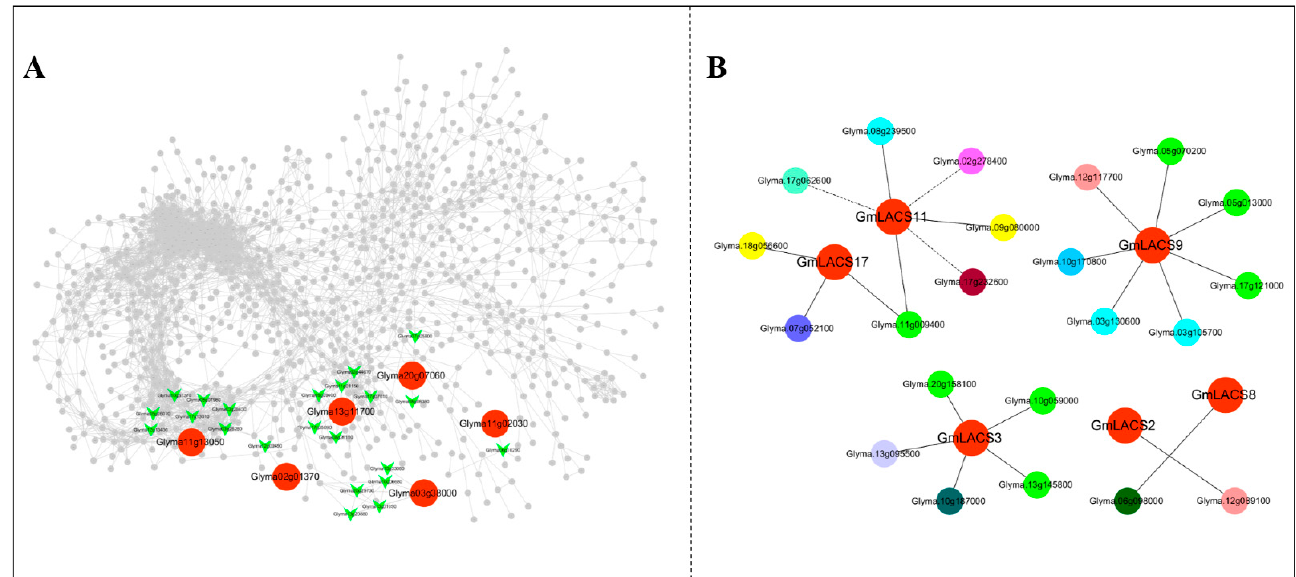
Figure 7. Co-expression network of transcription factors and LACSs in soybean. ( A ) Under drought stress; ( B ) Co-expression network of individual guide genes. When Pearson correlation is greater than 0.900, co-expression relationship is established, and a Perl script with the default value of 0.6 is used to build co-expression network. Different colored circles represent different transcription factors.